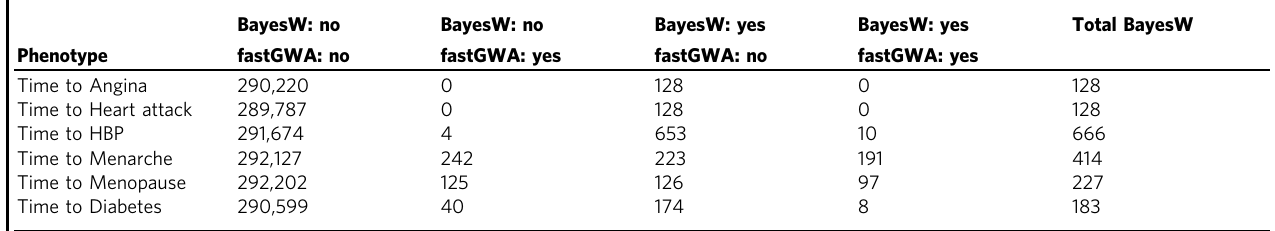
We split the genome into LD clumped regions and we evaluated the signi fi cance of each of the regions using the results from the groups BayesW model and the fastGWA model. The fastGWA results for our CAD and T2D de fi nition were missing so instead time-to-angina and time-to-heart attack are shown for CAD and time-to-diabetes is shown for T2D. Here, BayesW calls an LD clumped region signi fi cant if the PPWV of the region (explaining at least 0.001% of the genetic variance) is higher than 0.9; fastGWA calls an LD clumped region signi fi cant if there exists at least one marker with a p - value < 5×10 − 8 . We fi nd that although for age-at-menarche and age-at-menopause there exists an abundance of regions with concordant signi fi cance, for other traits most of the discovered regions differ betweentwo methods.For creating the comparisononly overlappingmarkers wereused; in the column TotalBayesWwe show the total numberof discoveredLD clumpedregions, includingthose that did not have a counterpart among fastGWA